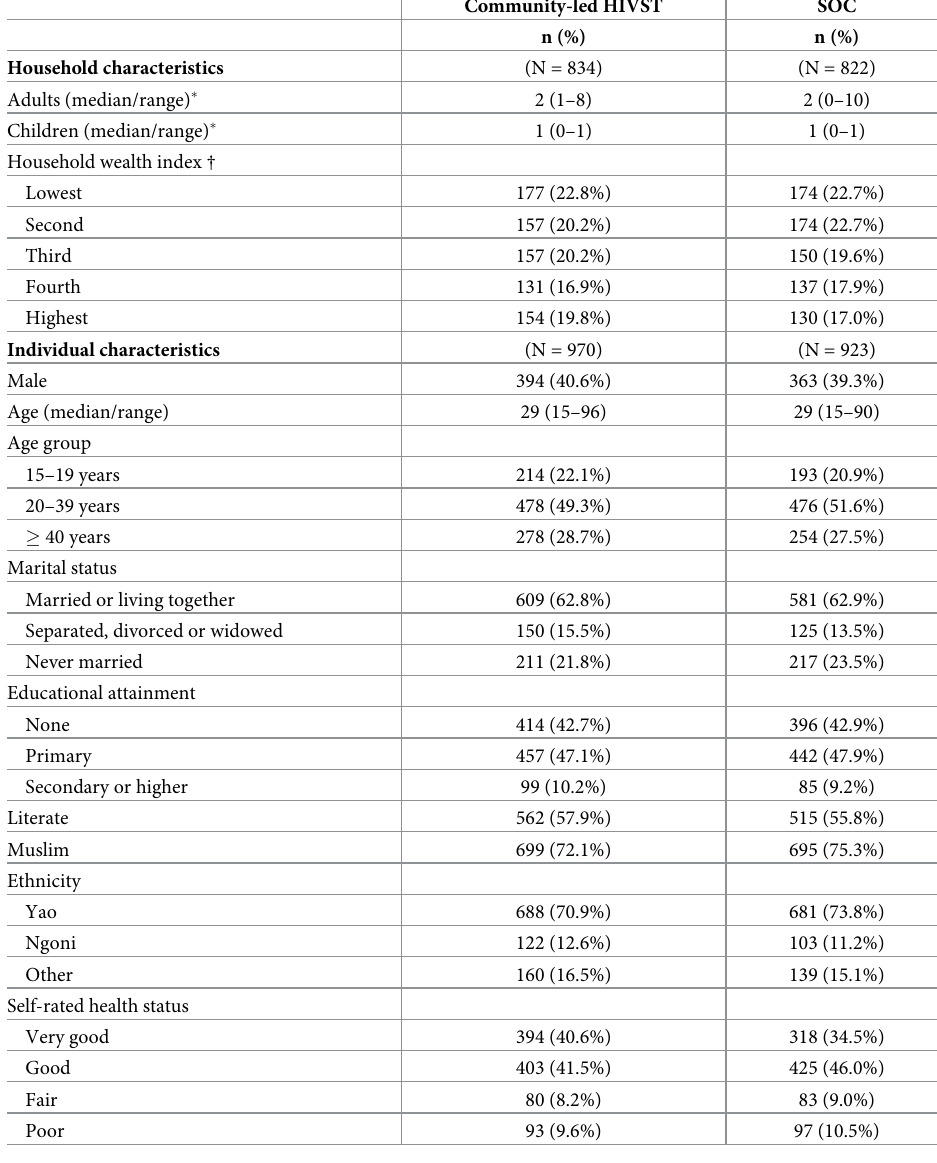
HIVST, HIV self-testing; SOC, standard of care.